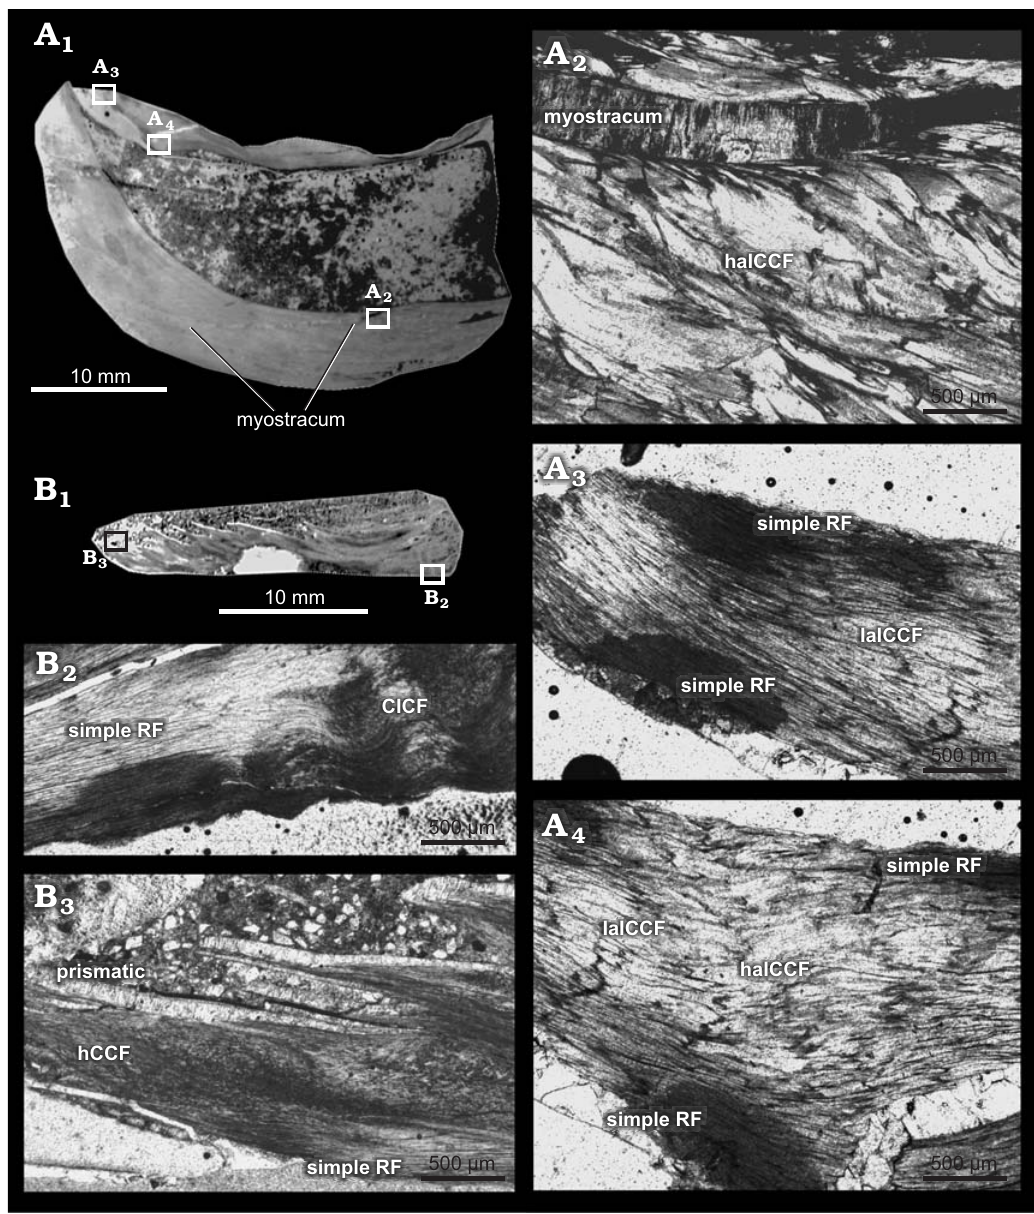
Fig. 7. Shell microstructure of pycnodontein oyster Pycnogryphaea weberae (Yanin in Tschelzova, 1969) from Berriasian of Crimea, section Balki village, Dalmasiceras tauricum Subzone. A . Thin section K-147-1 of left and right valves TsSGM 2088/36 with locations of photomicrographs (A 1 ); inner part of left valve with myostracum consisting of irregular simple prismatic microstructure, microstructure of valve represented by haICCF (A 2 ); umbonal part of right valve represented by simple RF and laICCF (A 3 ); inner part of right valve represented by simple RF, laICCF and haICCF. B . Thin section K-151- 10 of right valve with locations of photomicrographs (B 1 ); umbonal part represented by simple RF and CICF (B 2 ); outer part represented by hCCF and simple RF; exostracum consists of prismatic microstructure (B 3 ). CICF, chomata-influenced crossed foliated microstructure; hCCF, homogeneous com- plex crossed foliated microstructure; haICCF, high angle irregular complex crossed foliated microstructure; laICCF, low angle complex crossed foliated microstructure; RF, regular foliated